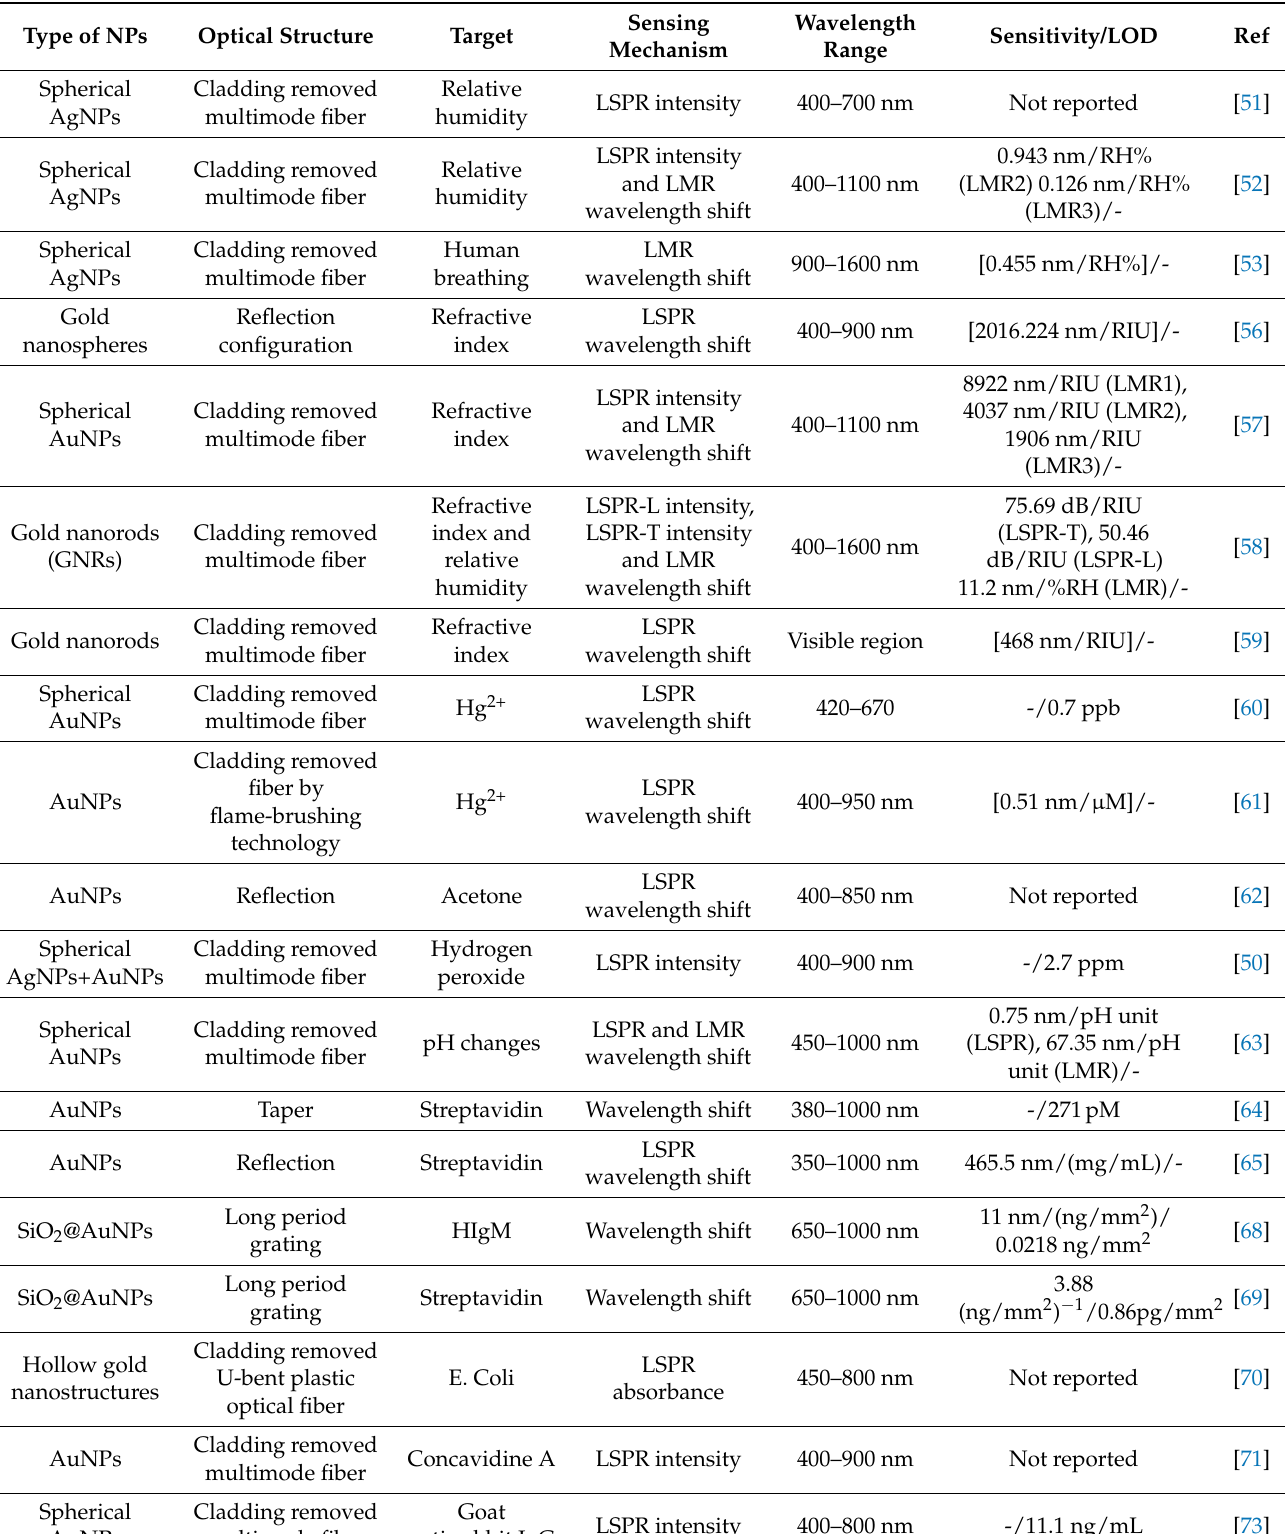
Table 2. Summary of the different optical fiber sensors composed of LbL assembled metallic nanoparticles with their corresponding optical structure, target of study, sensing mechanism, wavelength range and corresponding sensitivity. Type of